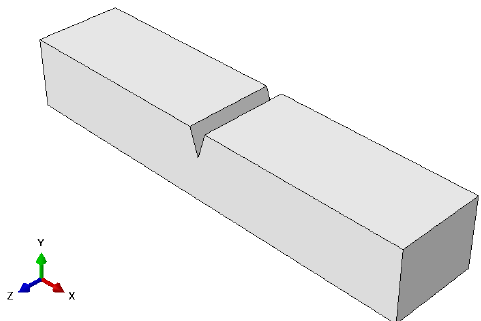
Figure 6. Finite element model of aluminum alloy specimen.